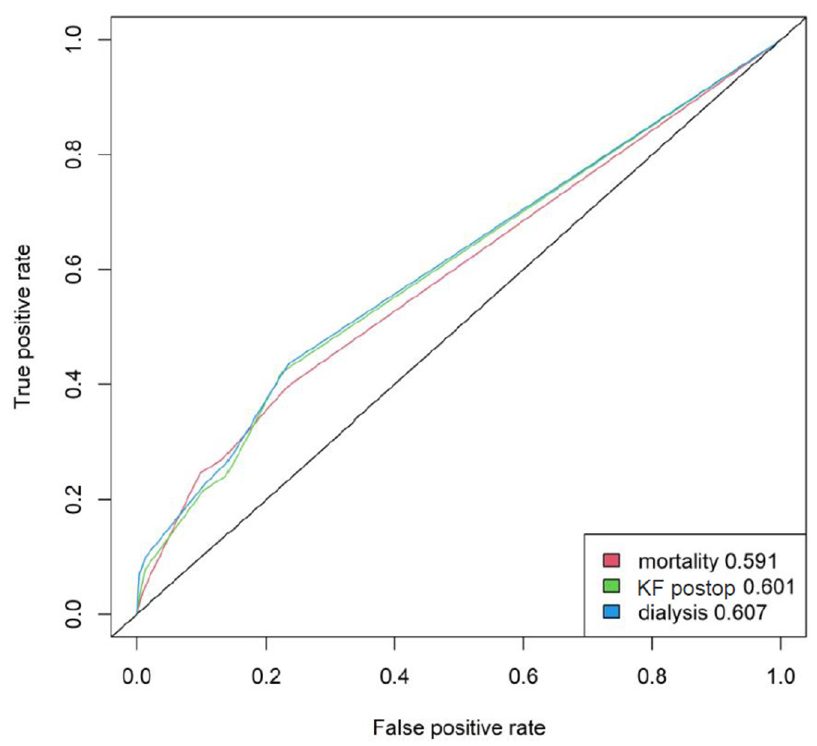
Figure 2. POC curve, KF postop: kidney failure postoperatively.